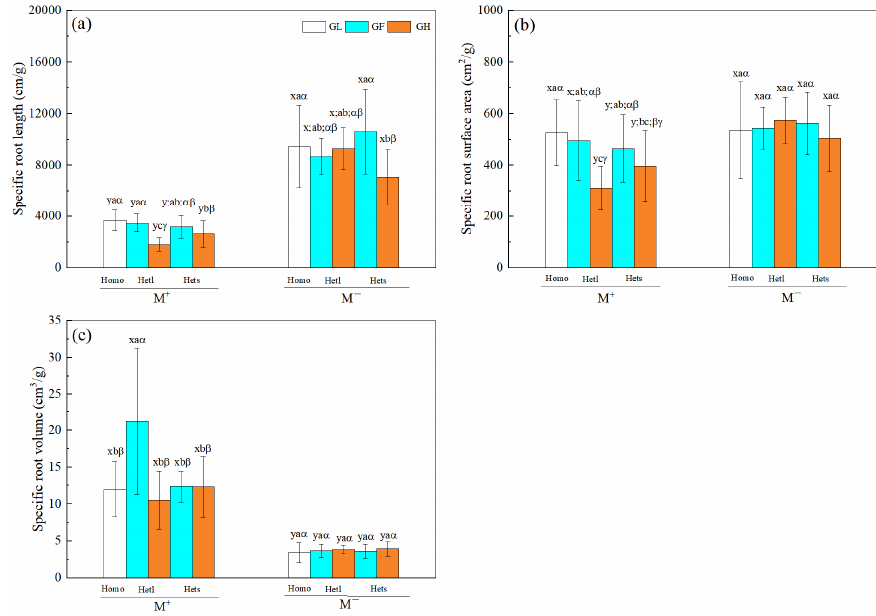
Figure 5. Specific traits of B. pilosa roots. ( a – c ) represent specific root length, surface area and volume, respectively. See Figure 2 for an explanation of M + , M − , Homo, Hetl, Hets, GL, GF, and GH, lowercase letters (x, y) and (a, b, c) and Greek alphabet ( α , β , γ ).